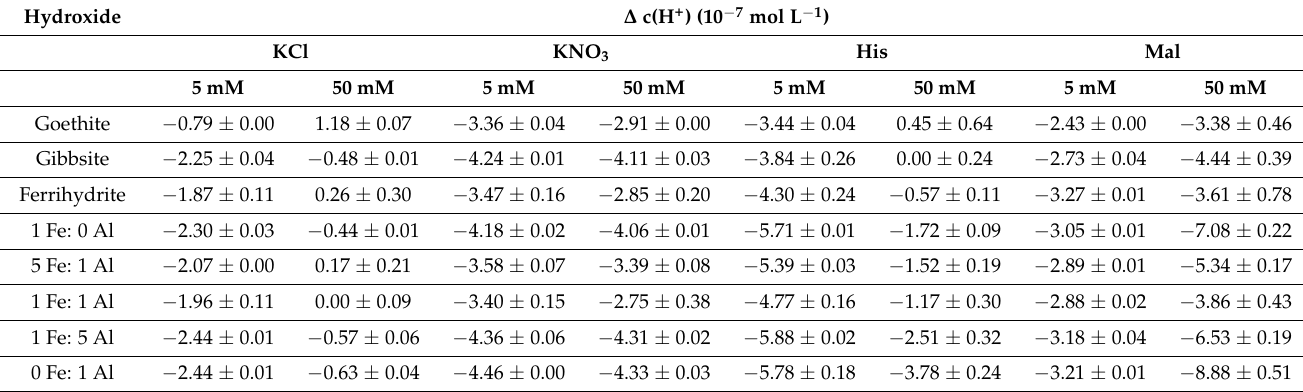
Table 7. Change of H + concentrations in the sample solutions after 2 h desorption